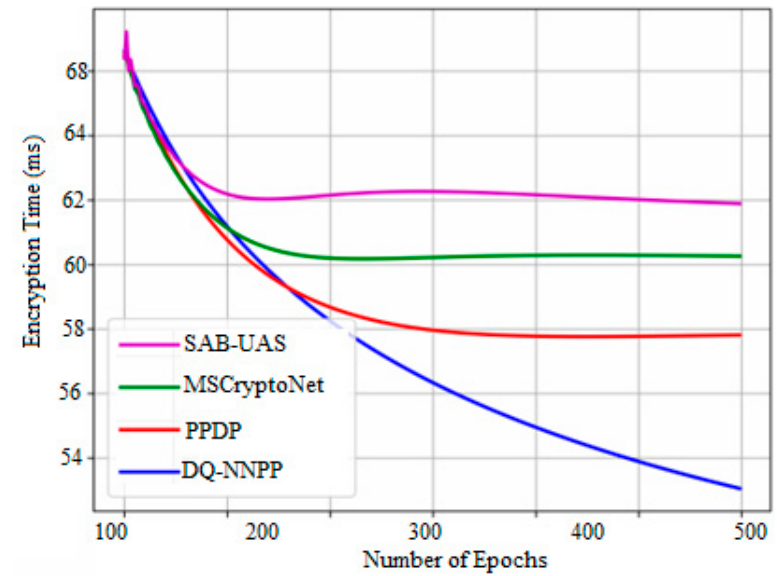
Figure 8. Comparison of encryption time.